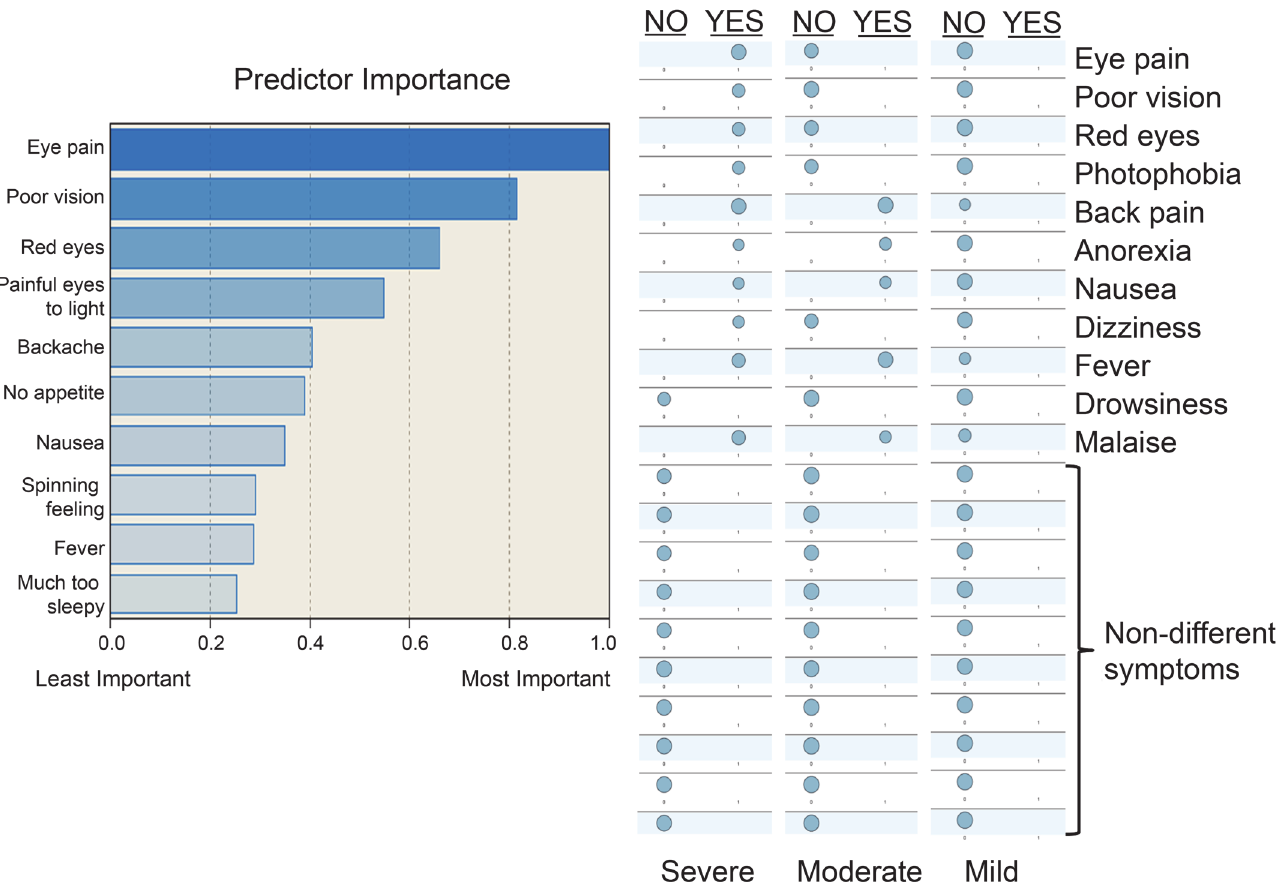
Fig 2. Summary of RVF symptom severity cluster analysis. With the use of two-step clustering algorithm, subjects who were seropositive for anti-RVFV IgG antibody were empirically grouped into three levels of symptom severity: mild, moderate and severe. The left panel indicates the relative importance (weight) of each symptom in assigning group membership. The right panel indicates the most typical profile of symptoms for subjects in each severity category. S2 Table provides numerical values for the symptom weights used in this classification.